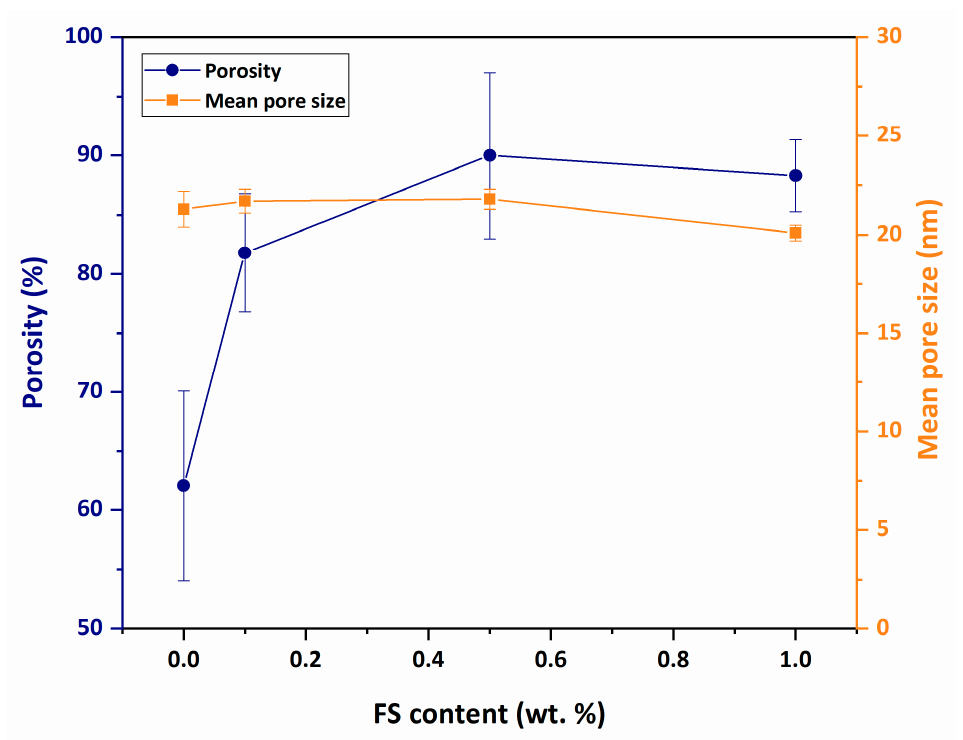
Figure 7. Porosity and mean pore size of PAN/FS